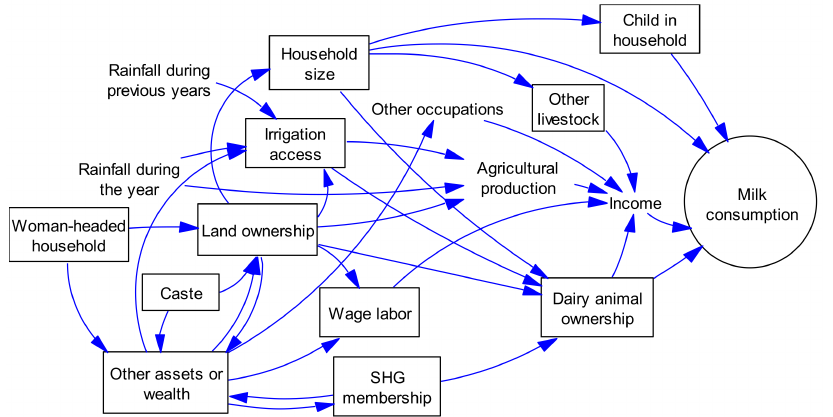
Figure 1. Factors potentially influencing milk consumption at household level in the study area (boxed variables have been included in the analysis); SHG, self-help